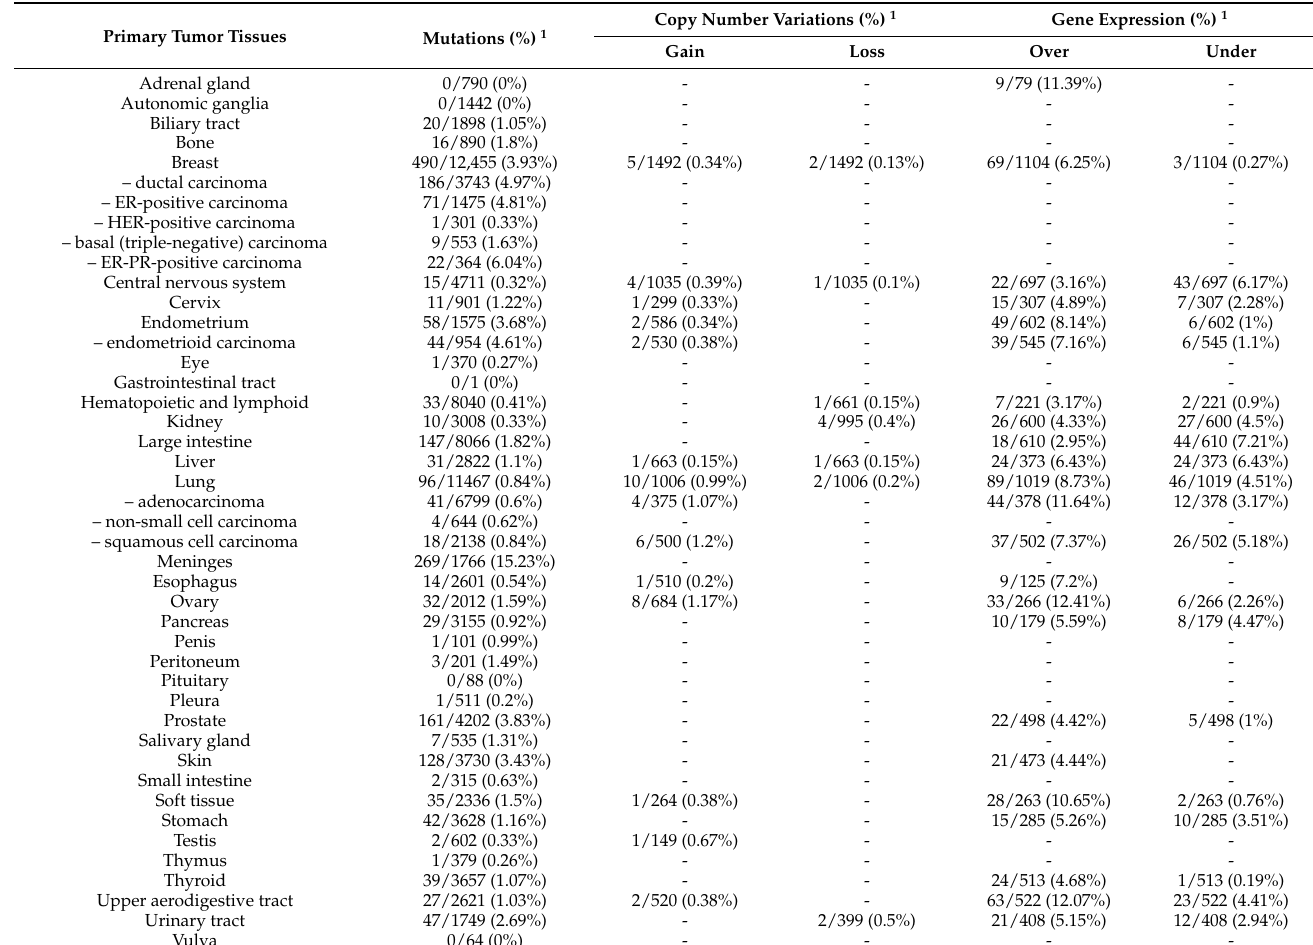
Table 2. Genetic alterations of the AKT1 gene in human